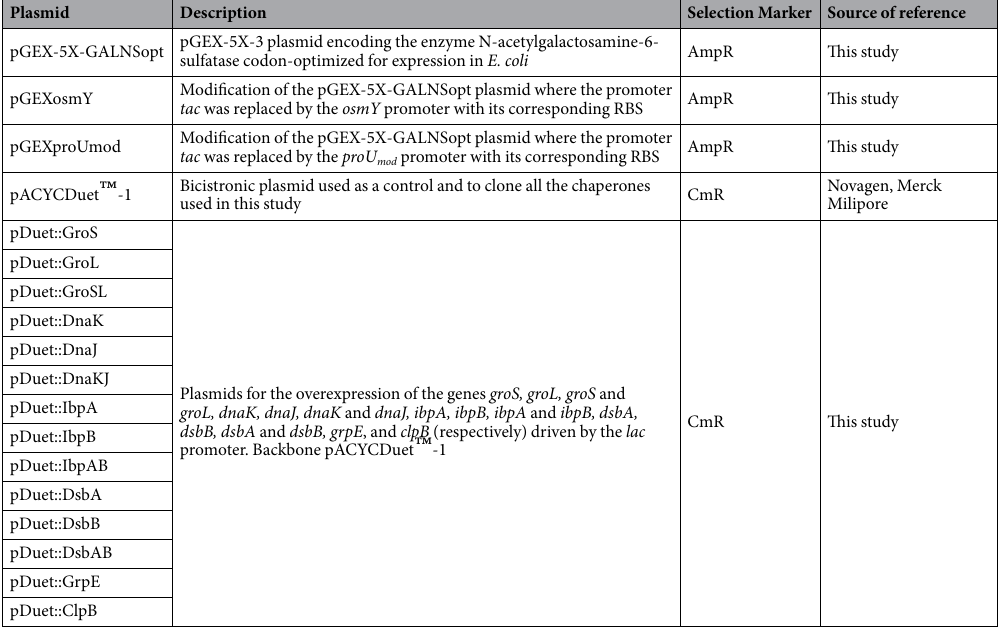
Table 1. List of plasmids used in this